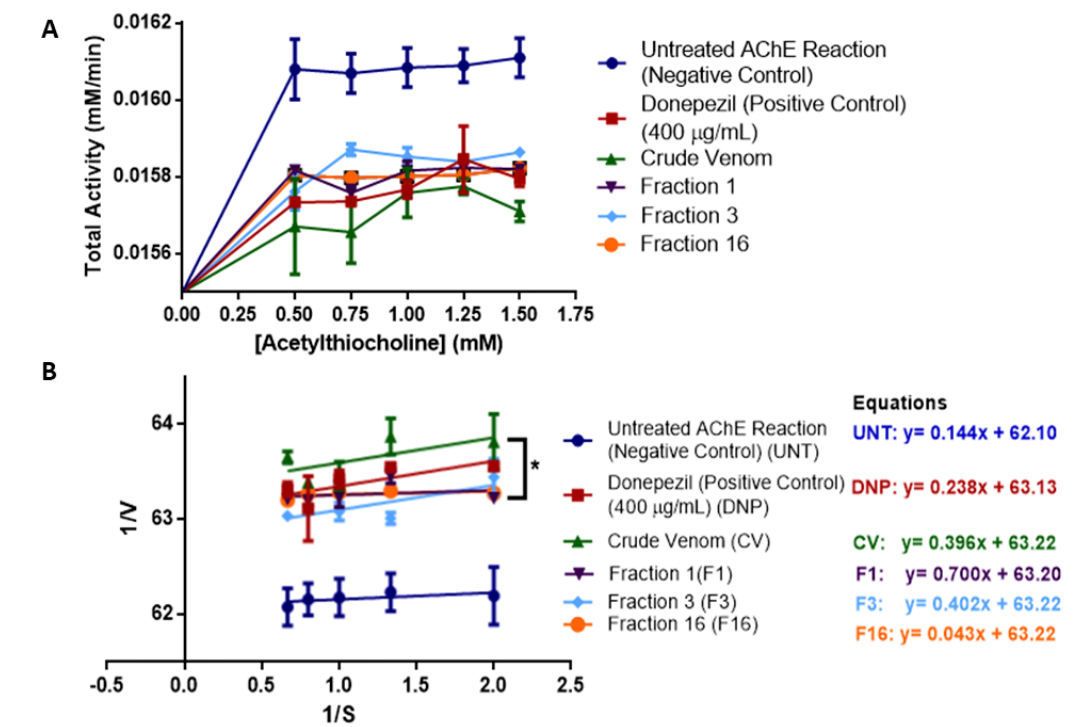
Figure 8. (A) Michaelis-Menten kinetics and (B) Lineweaver-Burk kinetics of venom fractions 1, 3, 16, whole venom in comparison with Donepezil and untreated AChE reaction. Data are reported as mean ± SEM (bars). Note: *p < 0.05 significant differences against the negative control value (untreated AChE reaction) (n = 3) (p = 0.001).